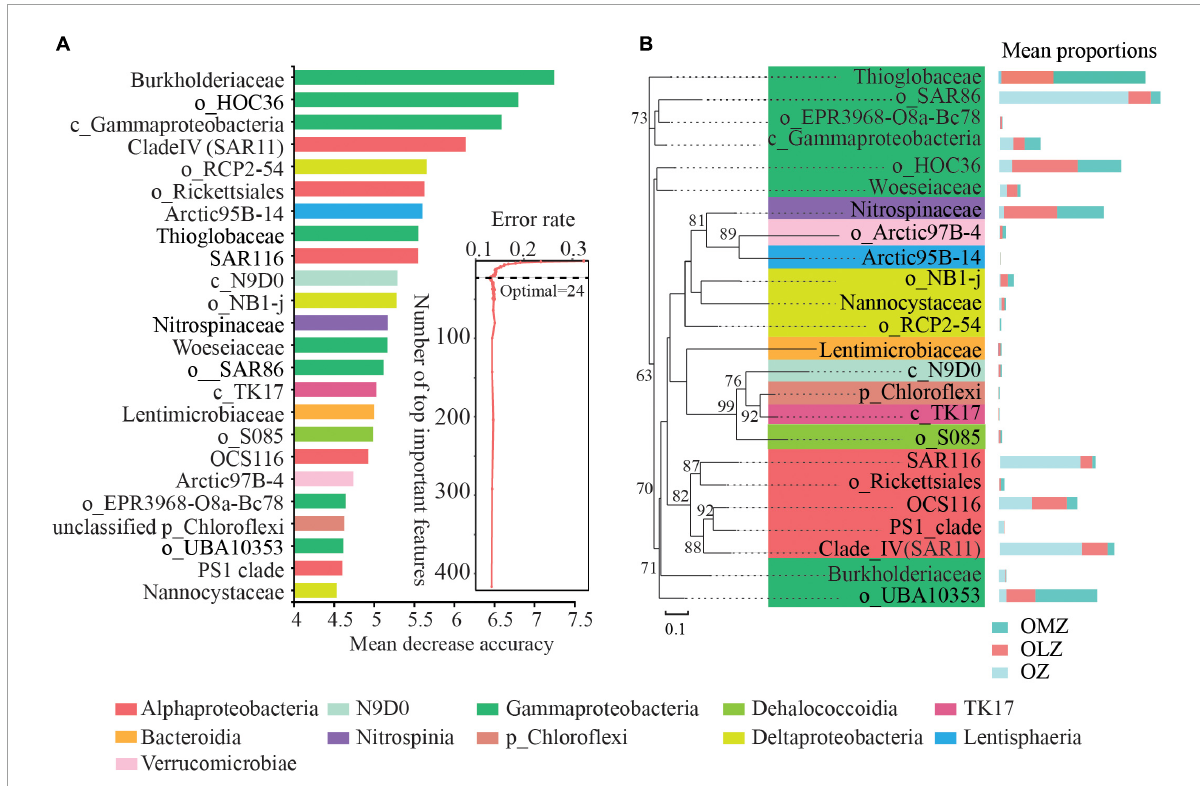
FIGURE5 Random forest modeling analysis detection of microbial biomarker taxa that significantly differentiate OMZ, OLZ, and OZ communities. (A) The 24 most discriminatory microbial families were identified by applying Random Forest classification of the relative abundances of populations in the OMZ, OLZ, and OZ communities. Biomarker taxa are ranked in descending order of importance to the accuracy of the model. (B) Phylogenetic analysis of biomarker families. Bars represent the relative abundances of microbial taxa in the OMZ, OLZ, and OZ